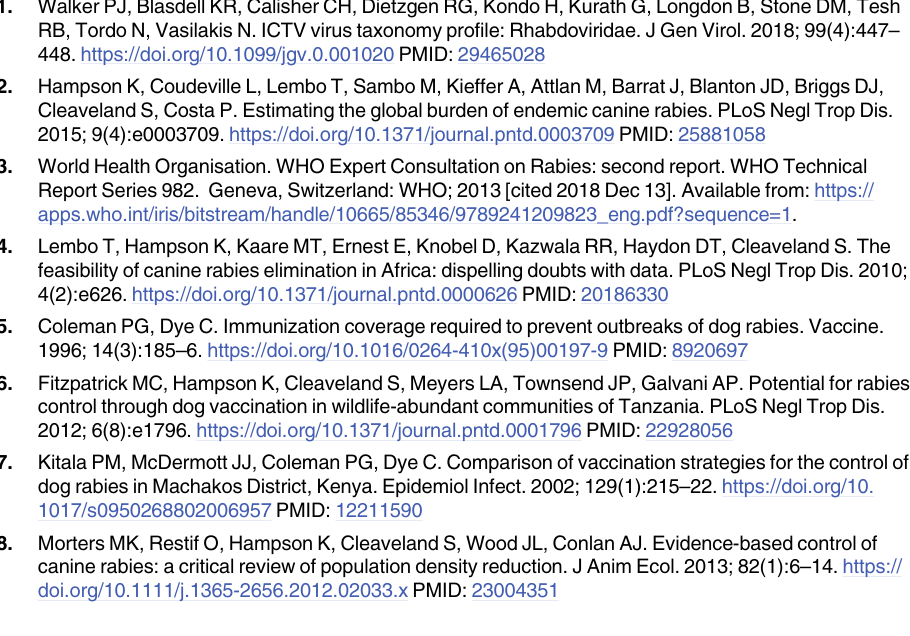
S1 Table. Additional information on serology studies in unvaccinated domestic dogs. Row number of study relative to Table 1 is shown. Information is provided on whether each study followed seropositive individuals to see if they developed rabies, evidence for previous vaccina- tion, notes on the test method used, and any additional information of use for interpreting the study results. S2 Table. Additional information on serology studies in unvaccinated wildlife. Row num- ber of study relative to Table 2 is shown. Additional information of use for interpreting the reported seroprevalence is shown. This includes whether low cutoffs were used, variation in test methods, and whether follow-up was carried out to check for development of